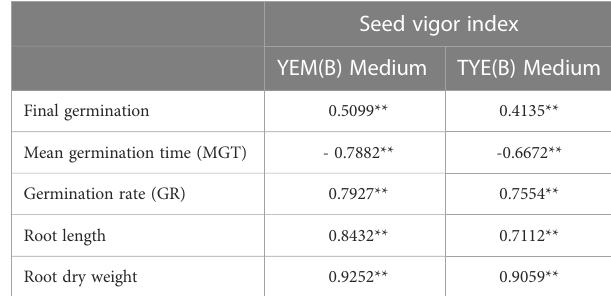
TABLE 1 The correlation coef fi cient of laboratory traits and seed vigor index of soybean.